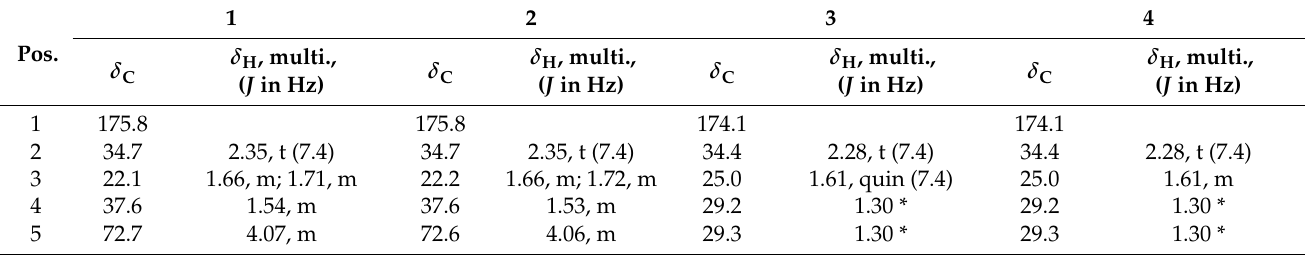
Table 1. 1 H and 13 C NMR spectroscopic data for compounds 1 and 2 in methanol- d 4 and 3 and 4 in chloroform- d